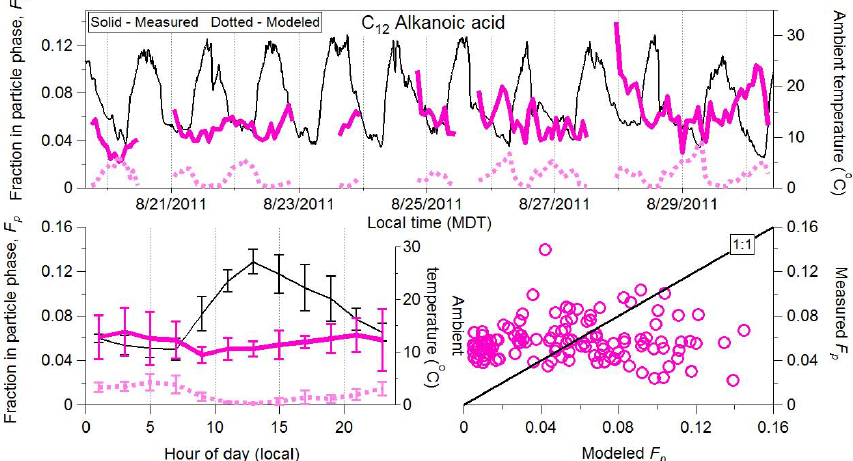
Fig. 10. Time series, diurnal cycle, and scatter plot of measured and modeled F p for C 12 alkanoic acid.